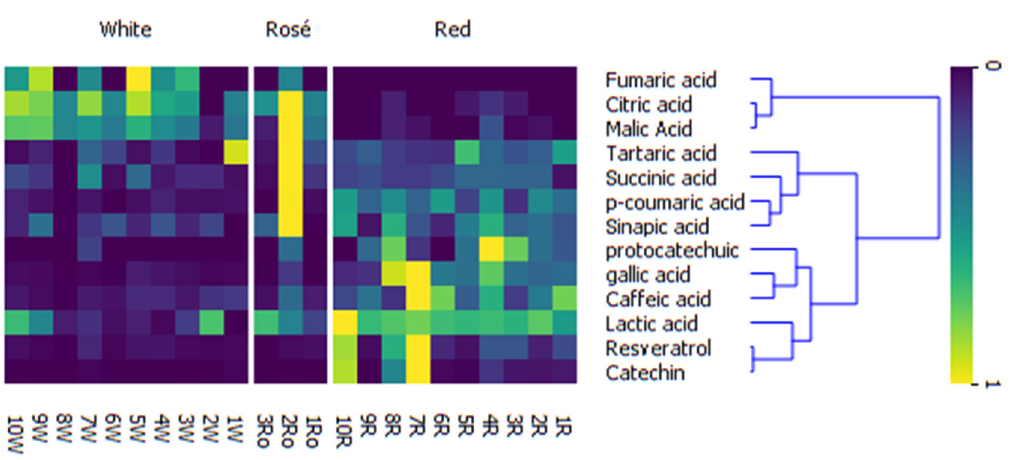
Figure 5. Heat map combined with hierarchical clustering with averaged linkage showing the difference in concentration of selected organic compounds and polyphenols in samples of white, red and ros é